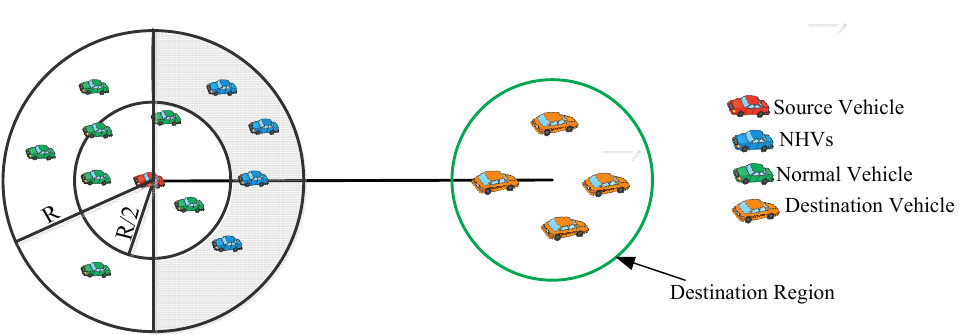
Figure 3. NHVs selection using